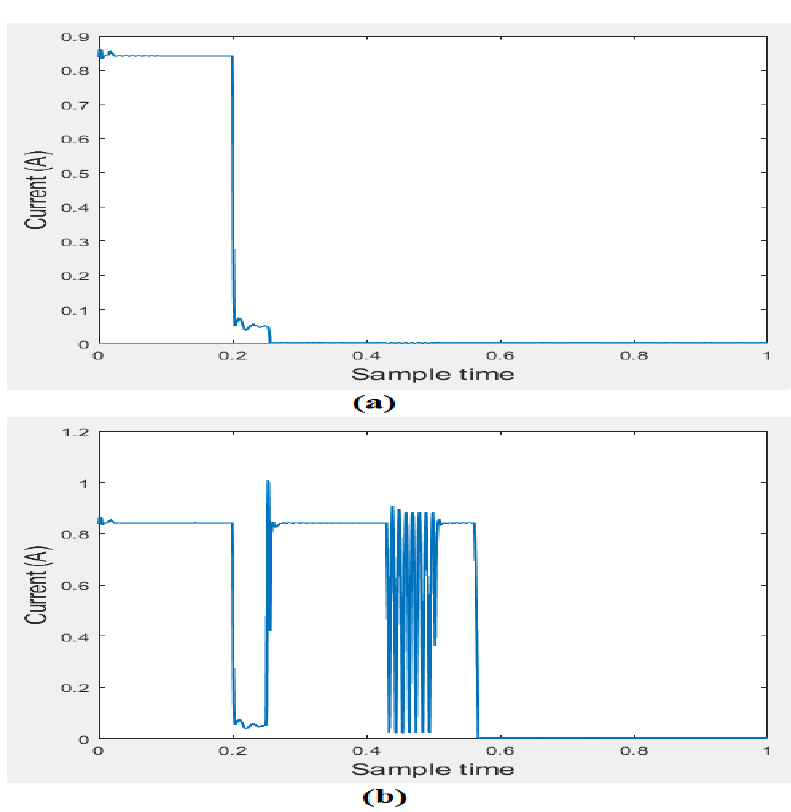
Figure 9. Current signal of L2: ( a ) MG 1 , ( b ) MG 2.